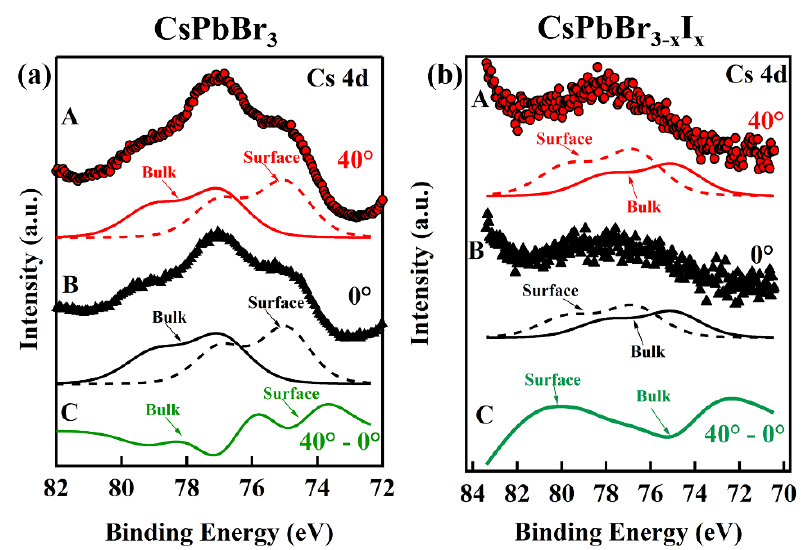
Figure 4. The Cs 4d core level XPS features of the single layer printed ( a ) CsPbBr 3 and ( b ) CsPbBr 3 − x I x Note: curve A is spectrum taken at an emission takeoff angle of 40°, with respect to the surface normal, the surface and bulk fitted curves of curve A are beneath; curve B is spectrum taken at emission takeoff angle of 0°, i.e., along the surface normal, with the surface and bulk fitted curves of curve B are beneath; curve C is the intensity difference between A and B indicating the surface contribution and the bulk contribution of the surface-to-bulk core level shift.